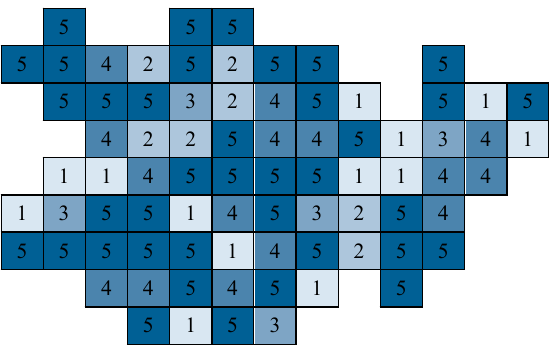
Figure 5. Technological model of coal deposit for matrix (78 × 4); 1—very small relative closeness; 2—small relative closeness; 3—medium relative closeness; 4—high relative closeness; 5—very high relative closeness.